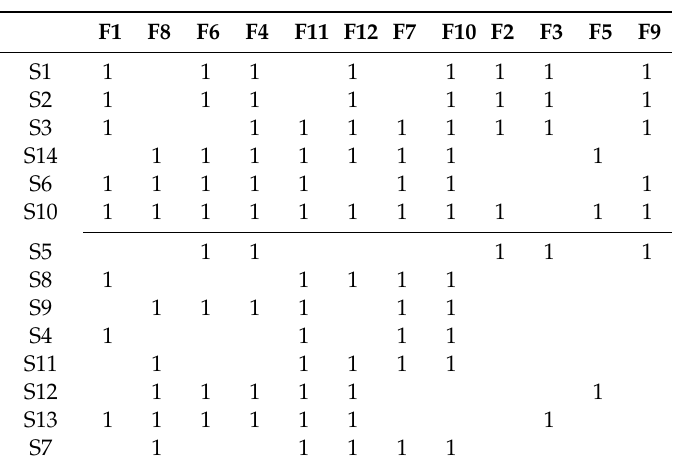
Table 4. Core–periphery structure model of the stakeholder–barrier